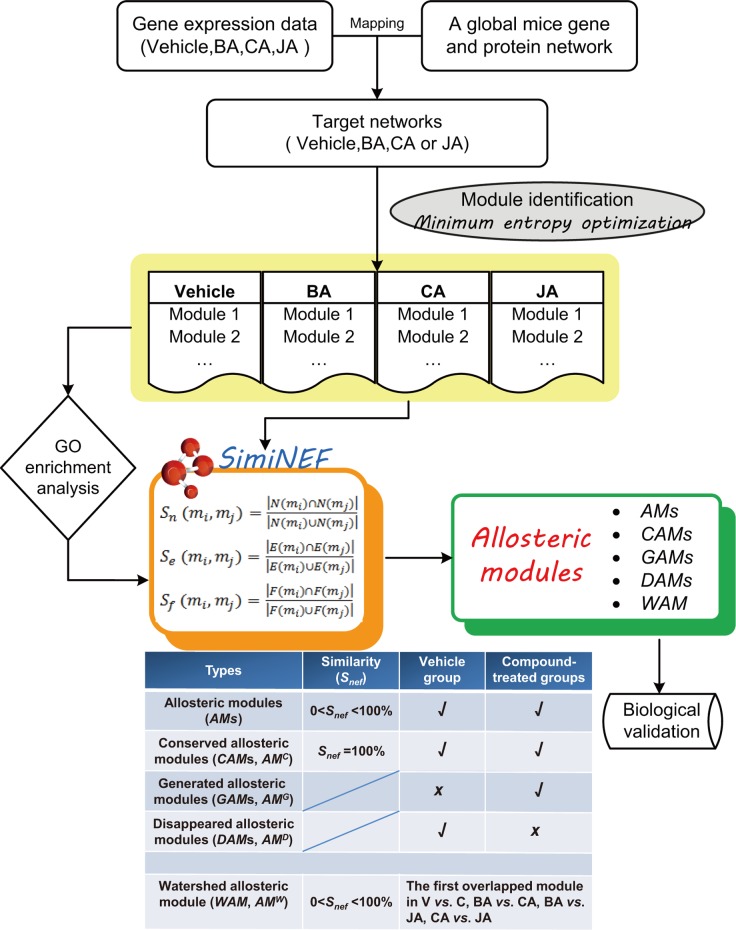
Flow diagram.Drug-target networks were constructed by integrating gene expression data and protein interaction data, and then functional modules were identified using the AP, MCL and MCODE algorithms, respectively. The results of module identification were then optimized based on the minimum entropy criterion. Enrichment analysis of GO biological processes and KEGG pathways was performed with the DAVID 6.7 software program. The similarity or overlap between modules was calculated using SimiNEF. Then, five different types of modular allostery were identified. We defined the five types of AMs as follows. (1) AMs. Most modules showed partial overlap (0<Snef <100%) between vehicle-treated and compound-treated groups, as well as between various compound-treated groups, and thus they were referred to as AMs. (2) Conserved allosteric modules (CAMs, AMC). If the similarity between vehicle-treated group and a compound-treated group reached 100% (Snef = 100%), these modules were referred to as CAMs. (3) Generated allosteric modules (GAMs, AMG). If a module was not found in the vehicle-treated group but could be identified in compound-treated groups, we defined it as a GAM. (4) Disappeared allosteric modules (DAMs, AMD). If a module was found in the vehicle-treated group but could not be identified in compound-treated groups, we defined it as a DAM. (5) Watershed allosteric module (WAM, AMW). 0<Snef <100%, the first overlapped module between vehicle-treated and compound-treated groups, as well as between various compound-treated groups, was referred to as the WAM. V = Vehicle, C = Compound. ‘√’ or ‘×’ represents its appearance ‘yes’ or ‘no’ in the group, respectively. Finally, two modules could be validated using RT-PCR and Western blotting, respectively.